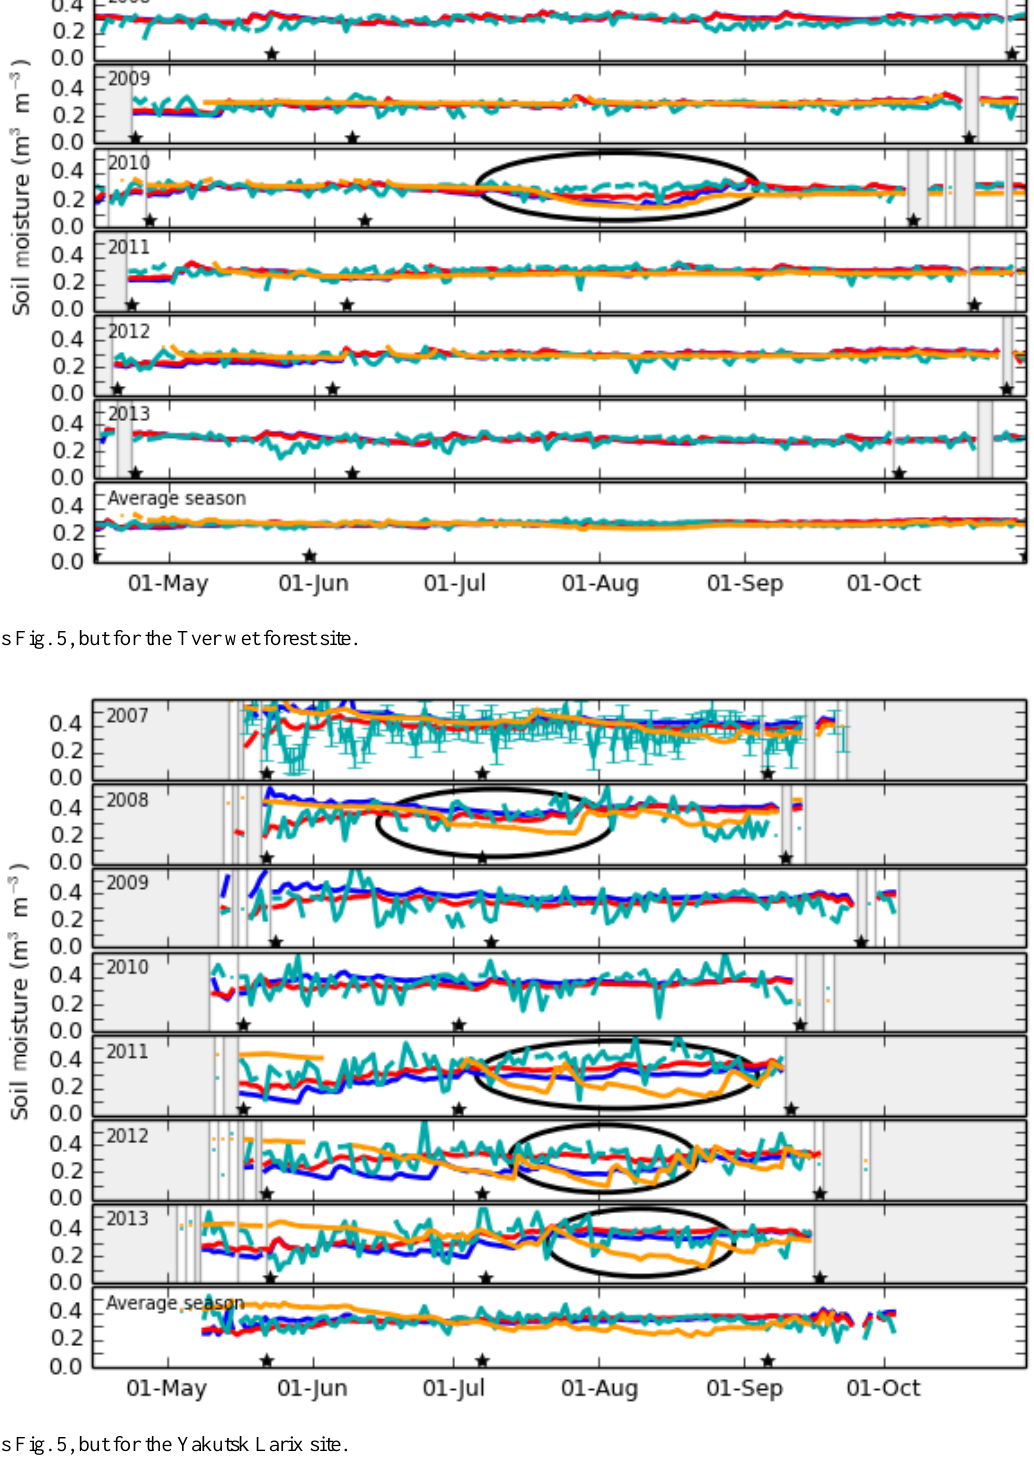
Figure 7. As Fig. 5, but for the Yakutsk Larix